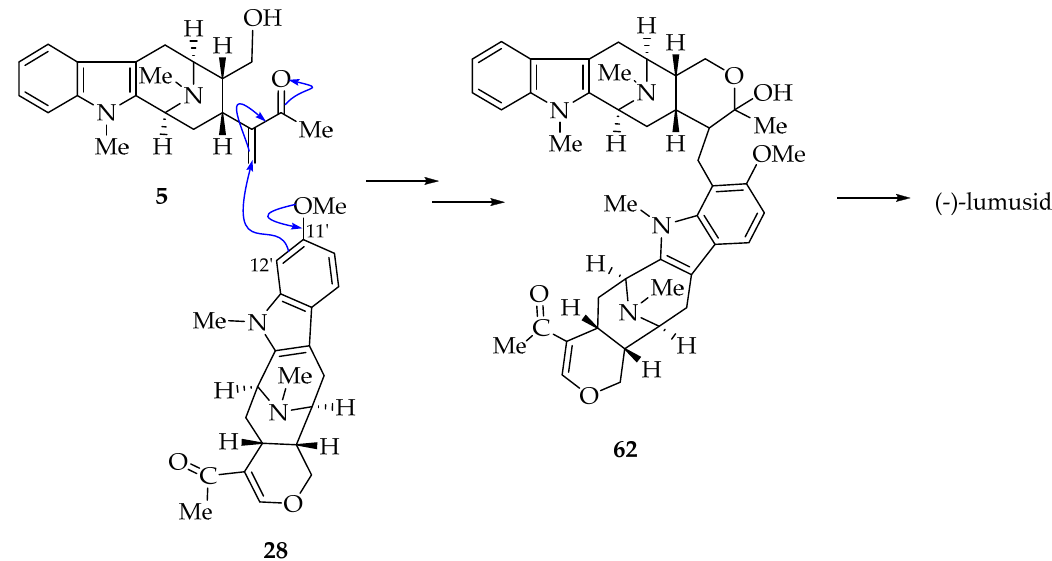
Figure 3. Putative biogenetic pathway to (-)-lumusidines A–D ( 14–17 )